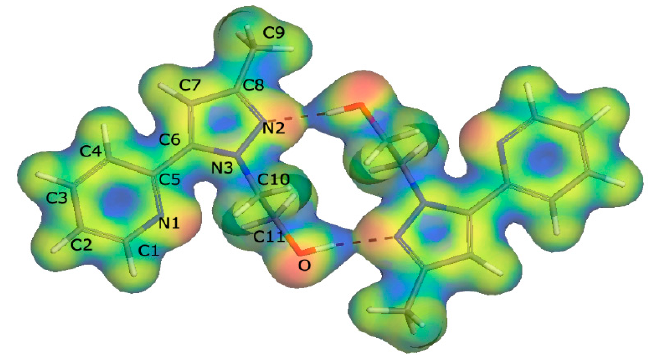
density represented in Figure 6 at the 0.15 iso-level.